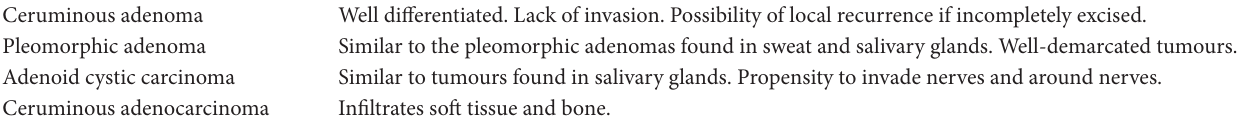
Table 1: Hidradenomata